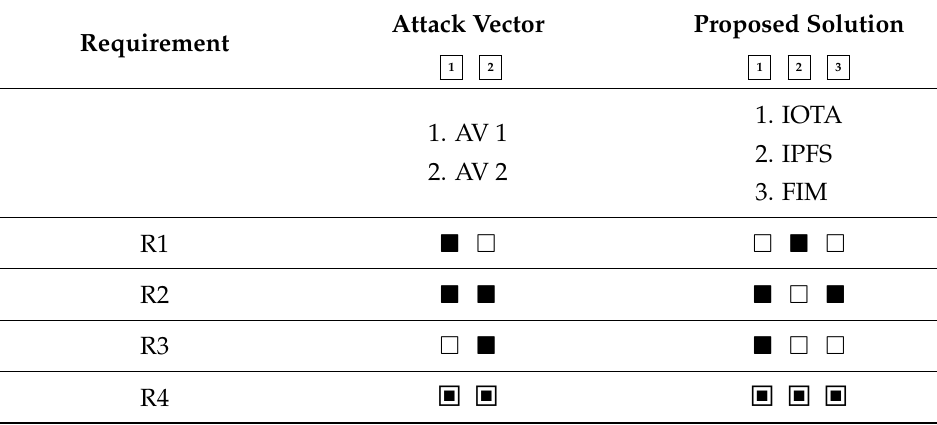
Table 2. Requirement fulfilment. Table 2. Requirement fulfilment. ▣ stands for not relevant. Table 2. Requirement fulfilment. ▣ stands for not relevant. Table 2. Requirement fulfilment. ▣ stands for not relevant. Table 2. Requirement fulfilment. ▣ stands for not relevant. Table 2. Requirement fulfilment. ▣ stands for not